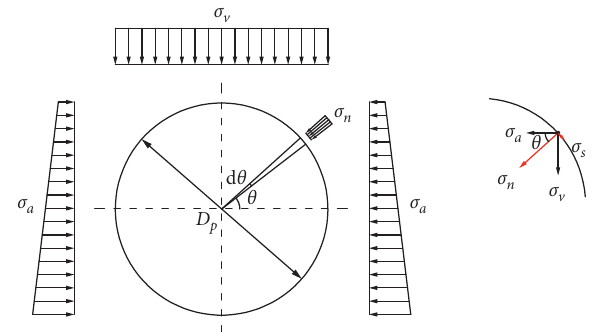
Figure 1: Earth pressure and the normal stress acting on the pipe.